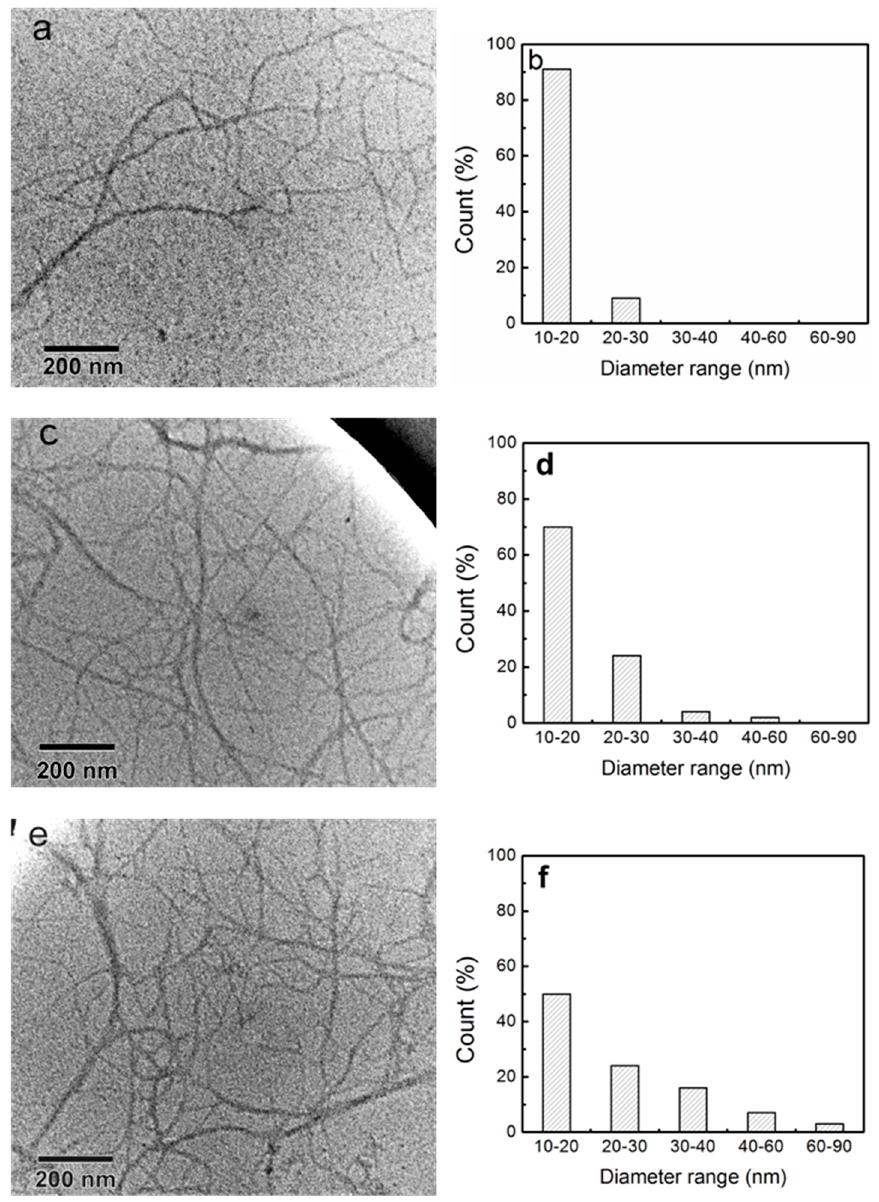
Figure 7. TEM images and diameter distributions of the CNFs: ( a , b ) CNF-I; ( c , d ) CNF-I/II; and ( e , f ) CNF-II.